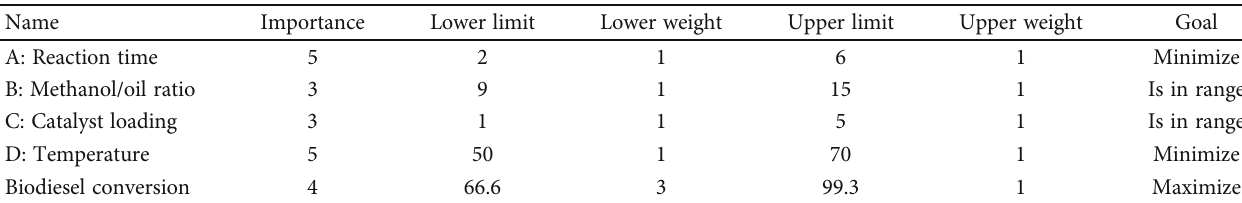
Figure 12: The link between biodiesel conversion, M:O ratio, and the reaction temperature interactions is given as a contour and surface graph. Table 6: Constraints for optimization.